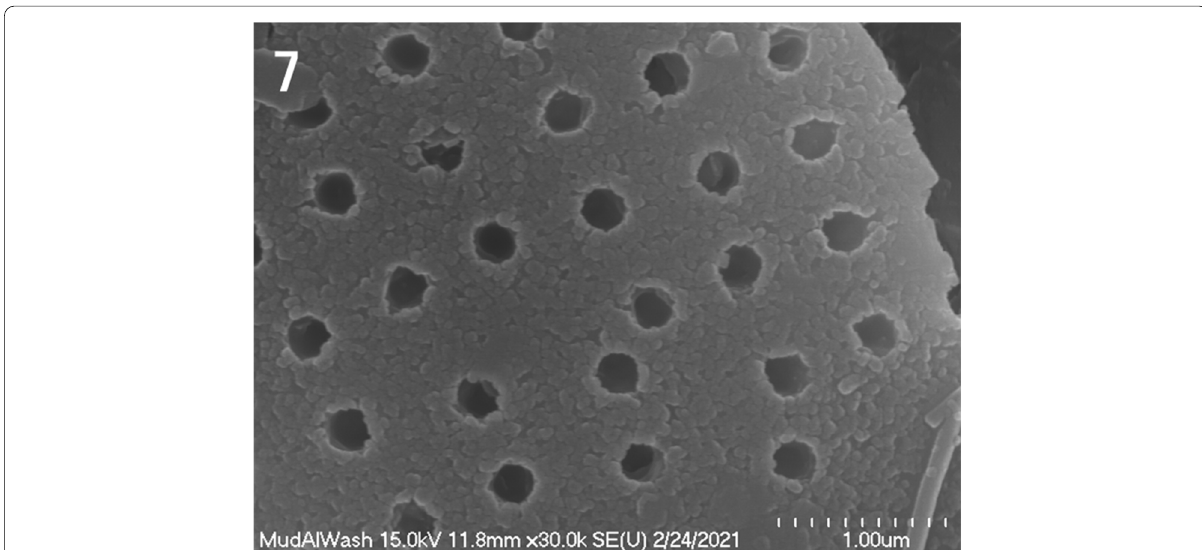
Fig. 7 Scanning electron micrograph of the diatom frustule. Note that the edge of the diatom frustule is circular and the pores are uniformly arranged on the surface